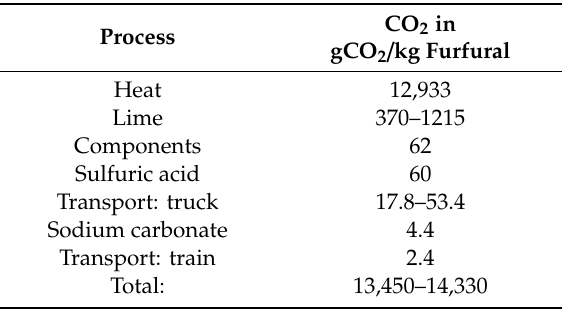
Table 5. CO 2 emissions in the production of furfural (using the Huaxia Furfural technology modified by Westpro).